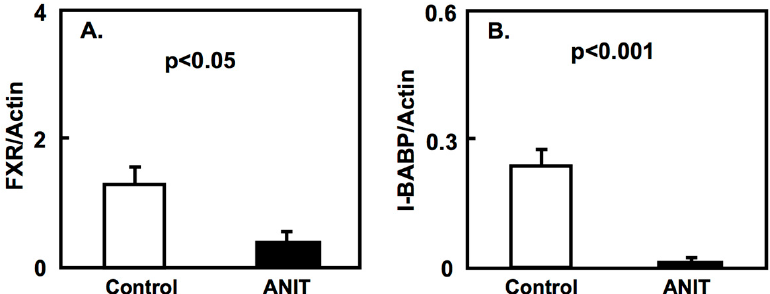
Figure 3. Intestinal expression of FXR and I-BABP in both control and ANIT rats. Intestinal mRNA levels of FXR ( A ) and I-BABP ( B ) in both groups ( n = 5 for each group) were examined by quantitative real-time PCR. Each bar represents the mean value ± SD and significant differences are indicated in the graph.